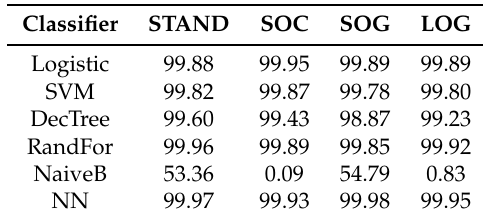
Table 2. Class-wise F-1 Score of Algorithms (%). Logistic: Logistic Regression, SVM: Support Vector Machines, DecTree: Decision Tree, RandFor: Random Forest, NaiveB: Naive Bayes, NN: Neural Network.